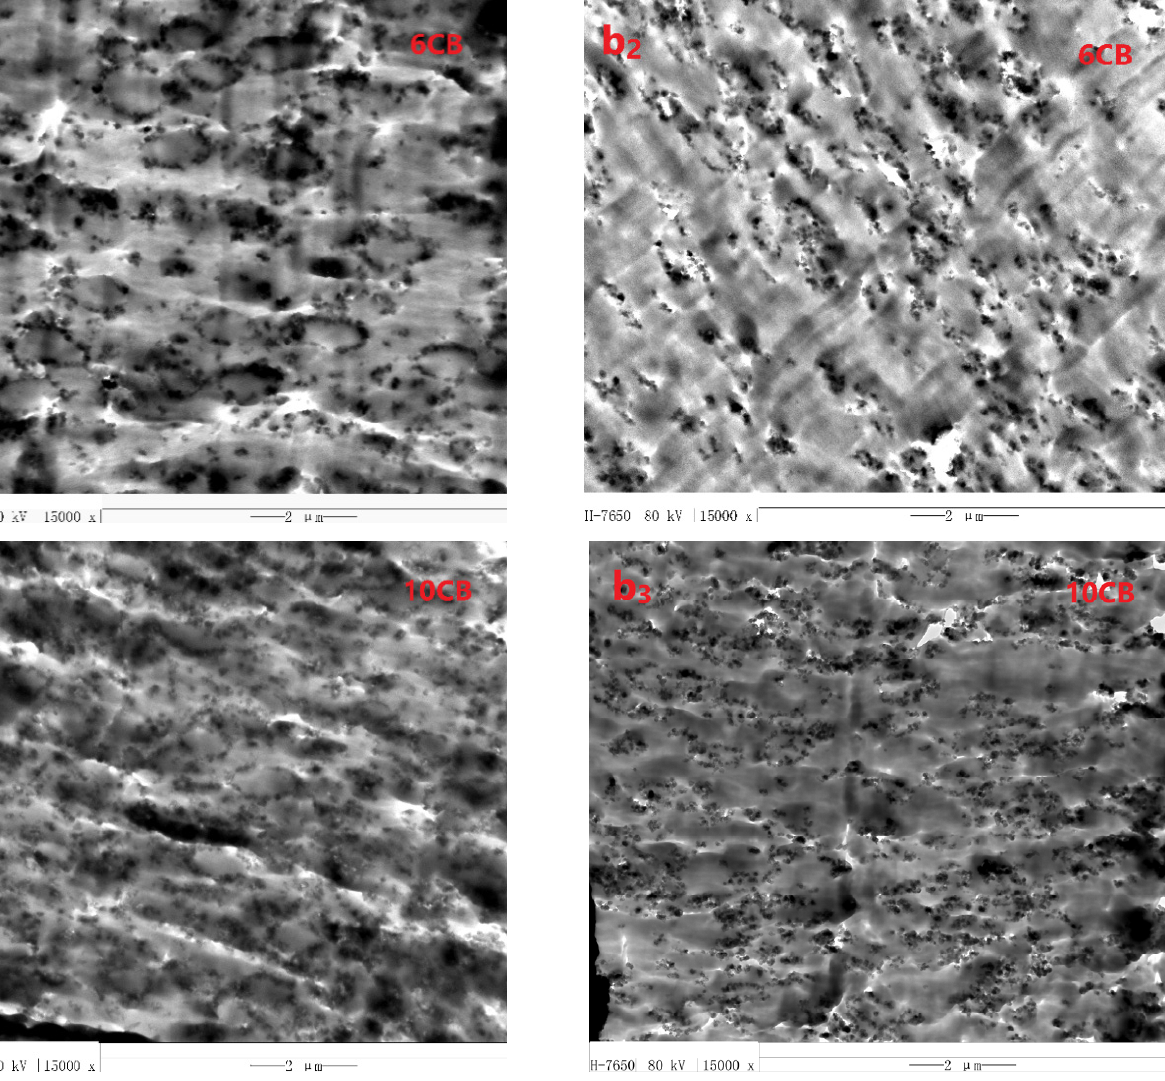
Figure 2. TEM micrographs of PA6/PBT(80/20)-CB ( a 1 , a 2 , a 3 ) and PA6/PBT(20/80)-CB ( b 1 , b 2 , b 3 ) composites containing different CB contents.